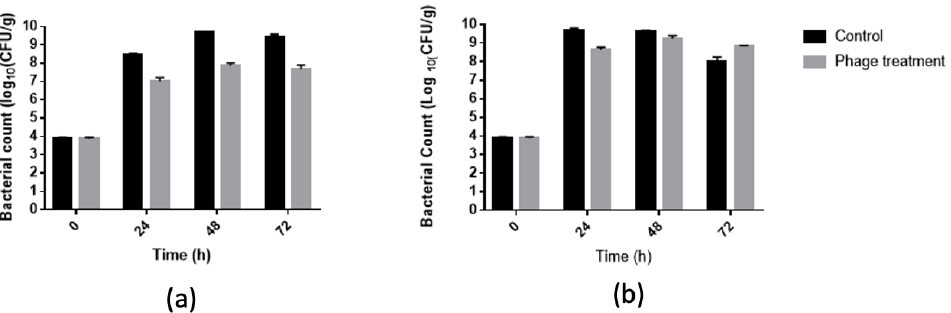
Figure 4. Evaluation of the antibacterial activity of phages cocktail in chicken meat to different temperatures ( a ) 22 °C and ( b ) 30 °C.